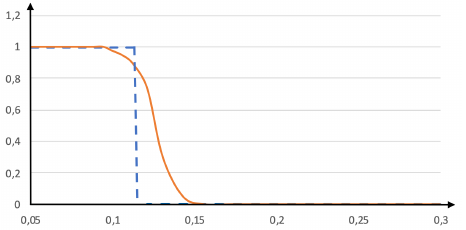
Figure 2. P 2 versus P 3 for the Runge function with α = 500. Comparison between the statistical frequencies (full line) and the probabilistic law (2.5) (dotted line). 500 meshes are used for each value of h